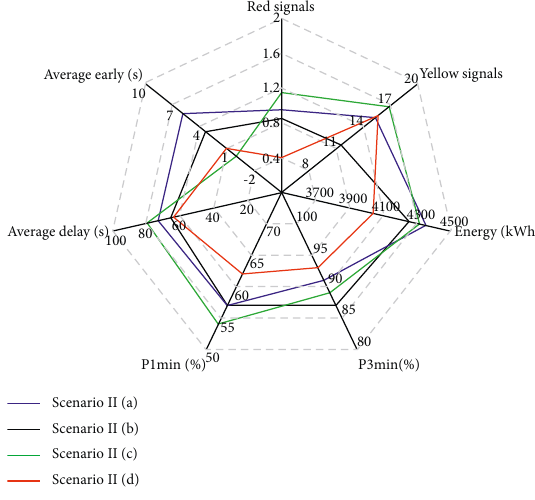
Figure 6: Results of Scenario